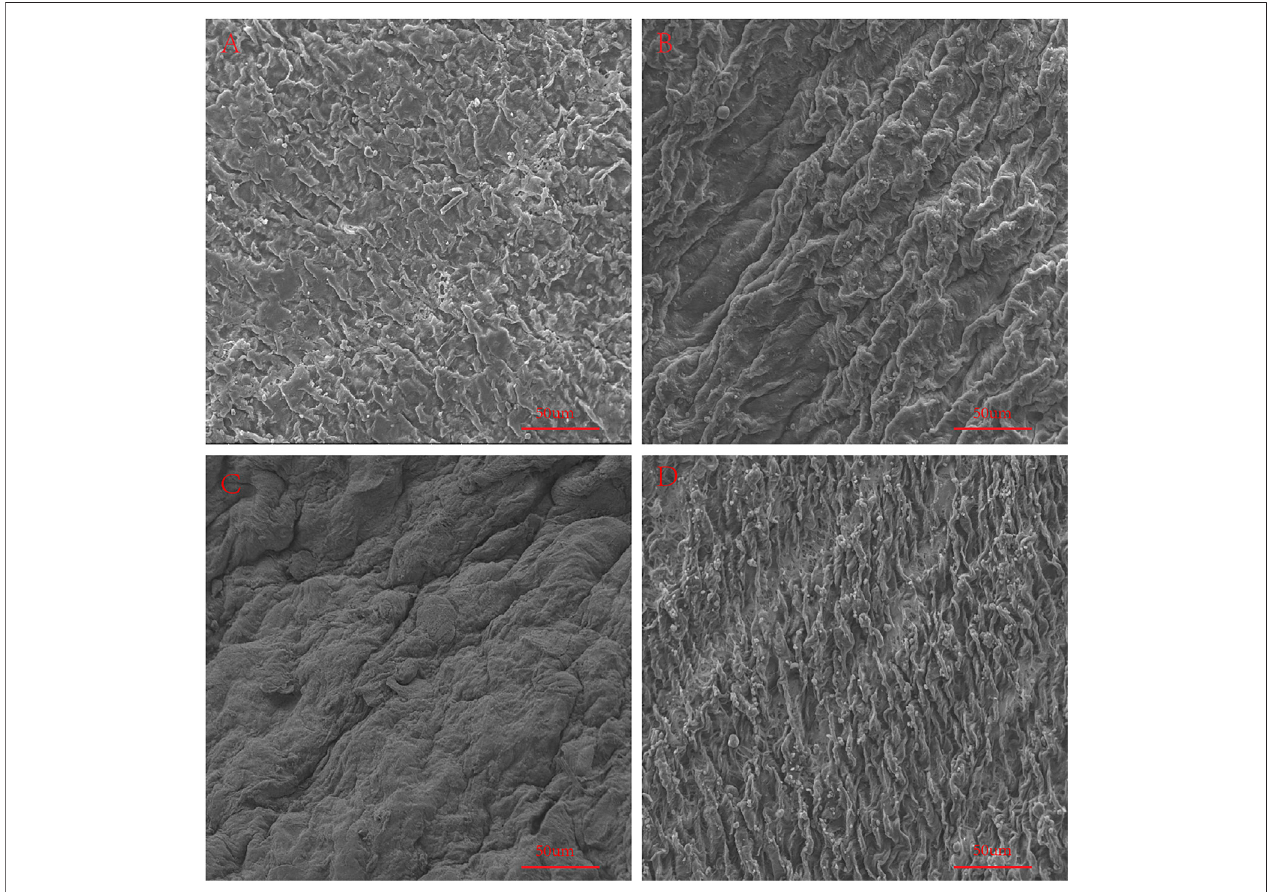
FIGURE7| SEMtoobservethesurfacestructureofGA-crosslinkedsamples. (A) ,GA-crosslinkedyakpericardium(GA-YP); (B) ,GA-crosslinkedAustralianbovine pericardium (GA-AP); (C) , GA-crosslinked local bovine pericardium (GA-LP); (D) , GA-crosslinked porcine pericardium (GA-PP). scale bars are 50 um.